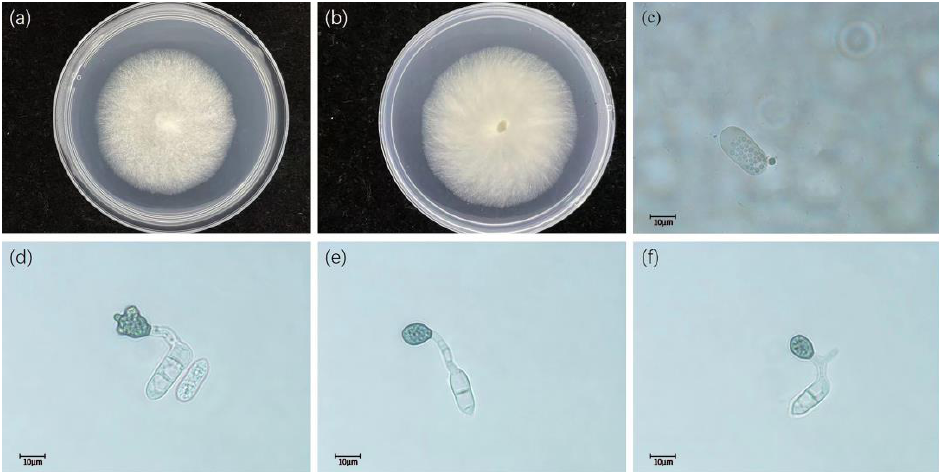
Figure 6. Colletotrichum camelliae (JXGZ18-1). ( a ) Colony on PDA. ( b ) Reverse side of the colony on PDA. ( c ) Conidia. ( d – f ) Appressoria. Scale bars = 10 µm.